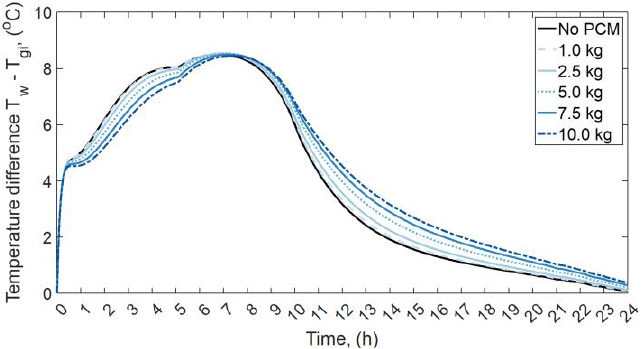
Figure 21. The temperature difference between water and inner glass cover in the SS with different masses of PCM — Case 4.